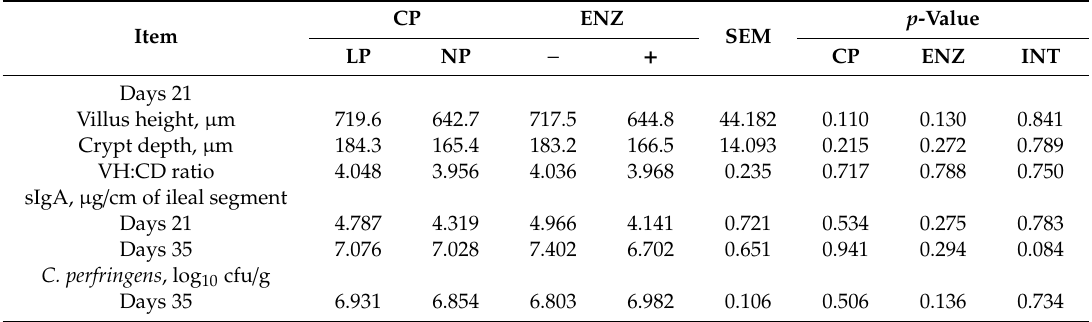
E ff ect of low-protein diet and exogenous protease on ileal morphology, secretory immunoglobulin A (sIgA), and C. perfringens counts in broiler chickens.